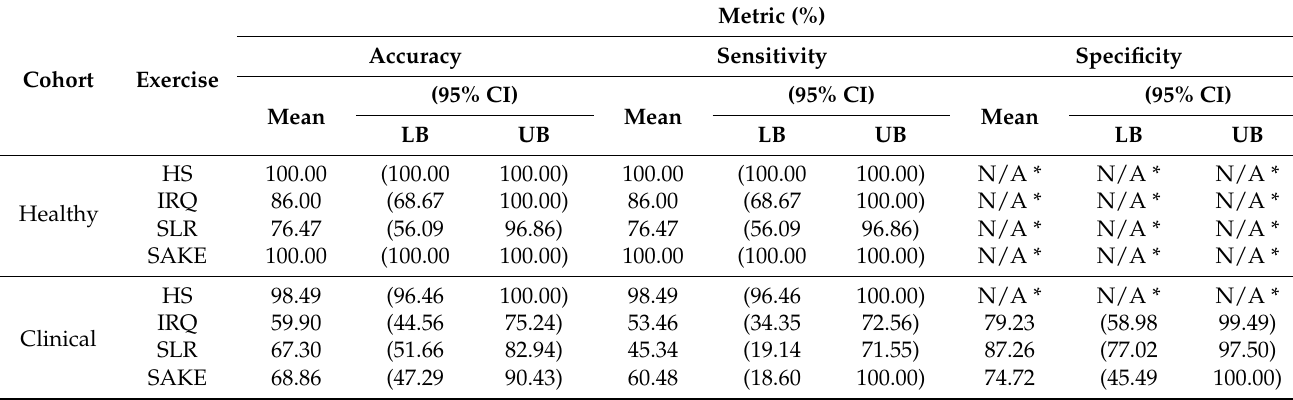
Table 7. Biofeedback model performance: classification results of healthy test data with segments generated automatically.